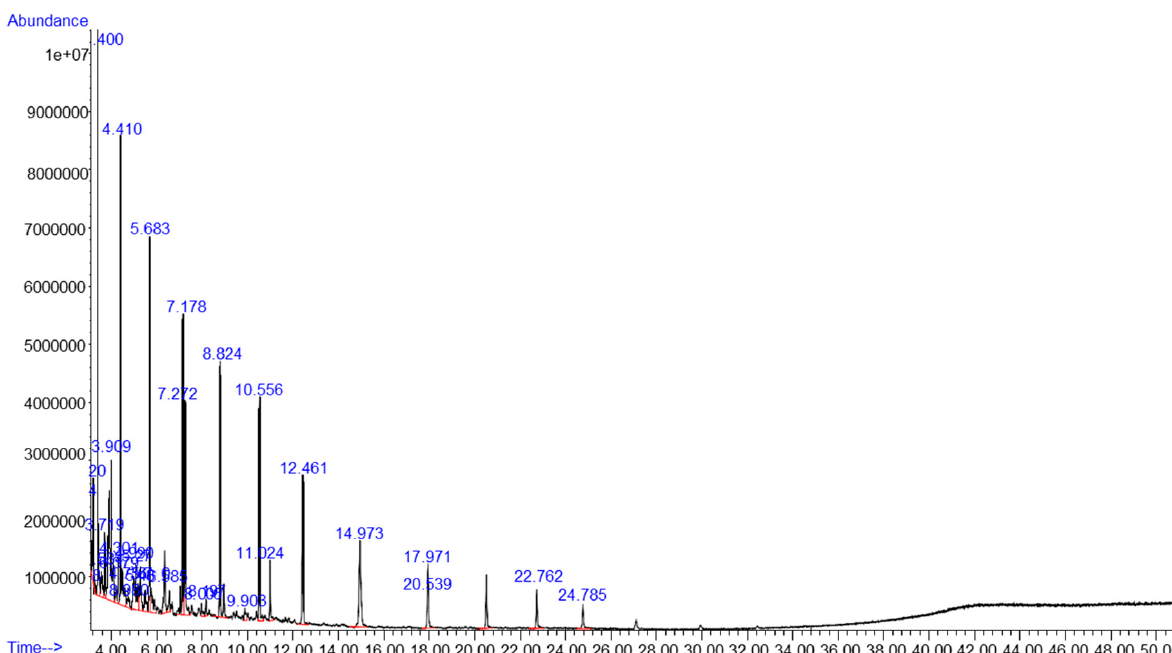
Figure 3. Gas chromatogram of diesel fuel.